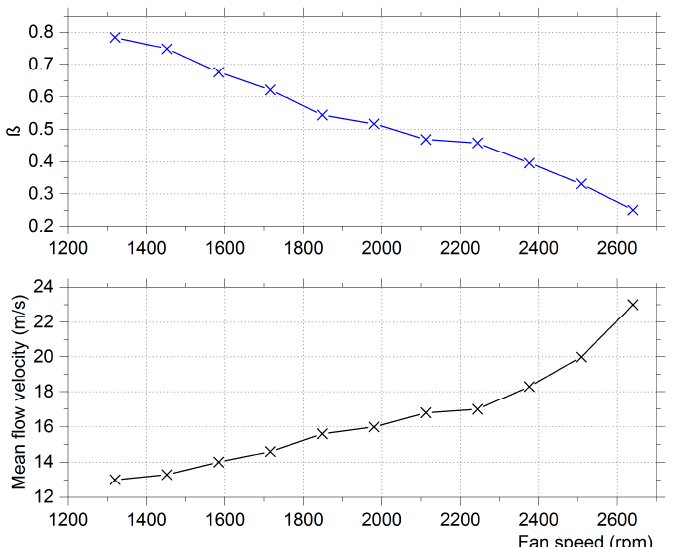
Figure 2. Dimensionless bending stiffness ( β ) and mean airflow velocity as functions of the fan’s speed.